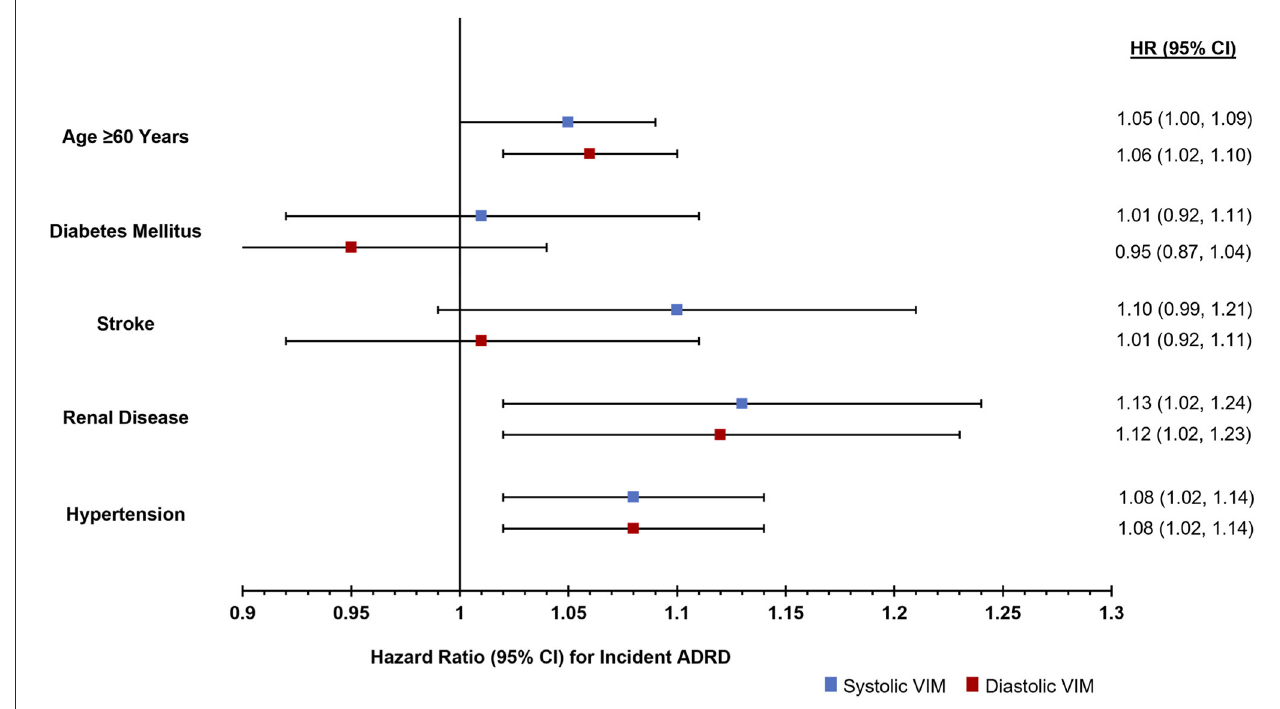
FIGURE1 Risk of incident ADRD diagnosis in the 2 years following an acute care hospitalization stratified by